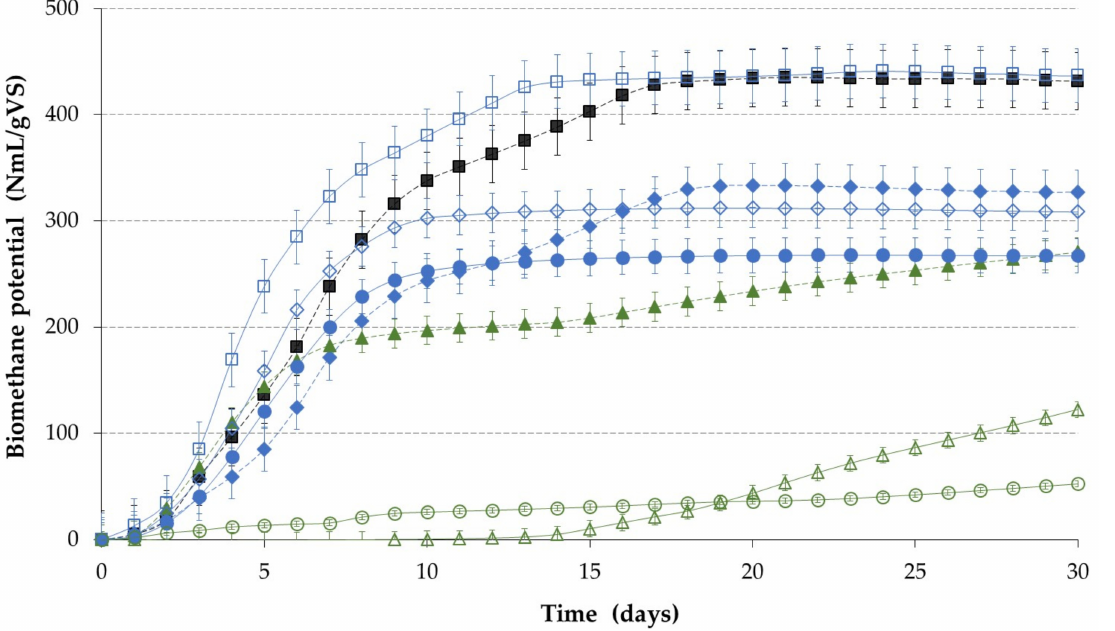
Figure 4. Assessment of the biomethane potential of the eight biodegradable plastics (Products 1 to 8) used in the study on the basis of methane (CH 4 ) development under anaerobic digestion conditions. Product 1 ( (cid:4) , black dashed line), Product 2 ( (cid:3) , blue solid line), Product 3 ( (cid:7) , blue dashed line), Product 4 ( (cid:52) , green solid line), Product 5 ( (cid:78) , green dashed line), Product 6 ( ♦ , blue solid line), Product 7 ( • , blue solid line), Product 8 (o, green solid